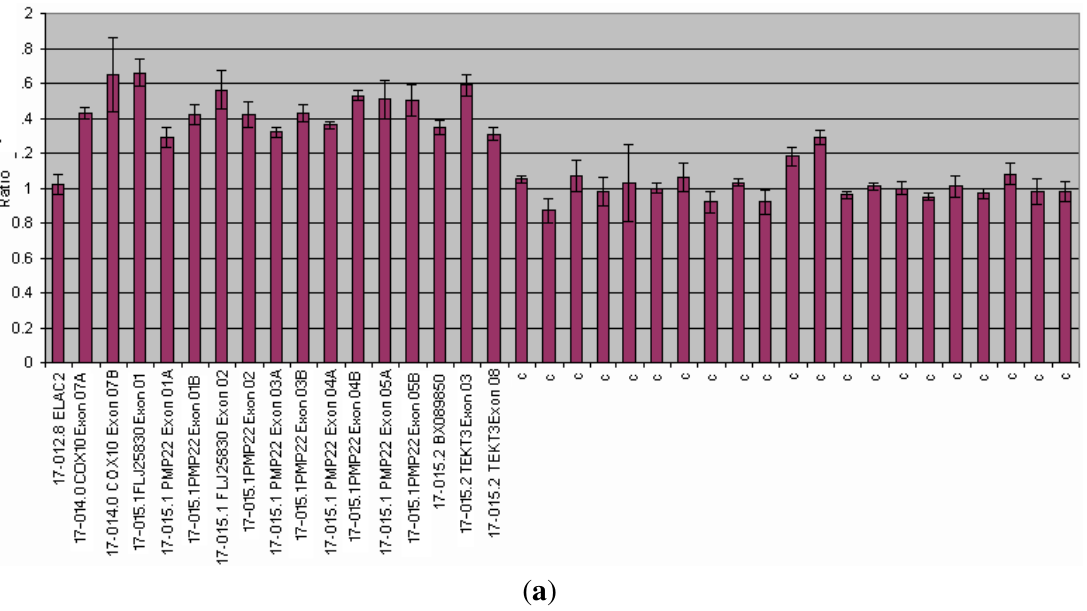
Figure 2. MLPA analysis of the PMP22 gene. Abscissa represents PMP22 gene and control probes (c); ordinate represents fluorescent intensity of amplification. For each probe, the ratio <0.75 stands for deletion; and the ratio >1.3 stands for duplication. ( a ) duplication of the PMP22 gene (ratio > 1.3) in a patients affected by Charcot Marie Thoot (CMT) disease; ( b ) Normal control (075 < ratio <